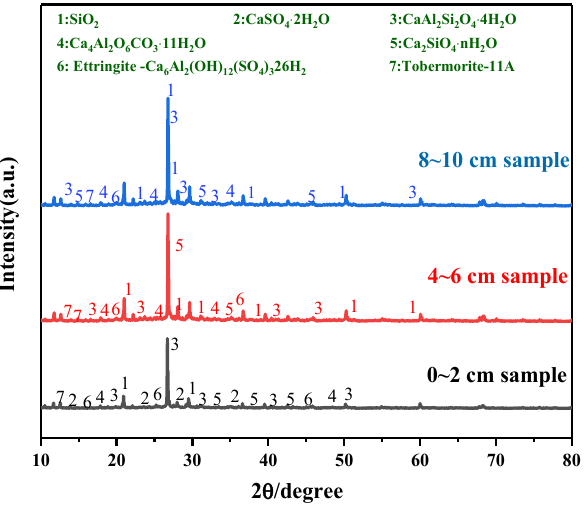
Figure 7. X-ray diffraction pattern of MS7 modified dredged sludge sample.